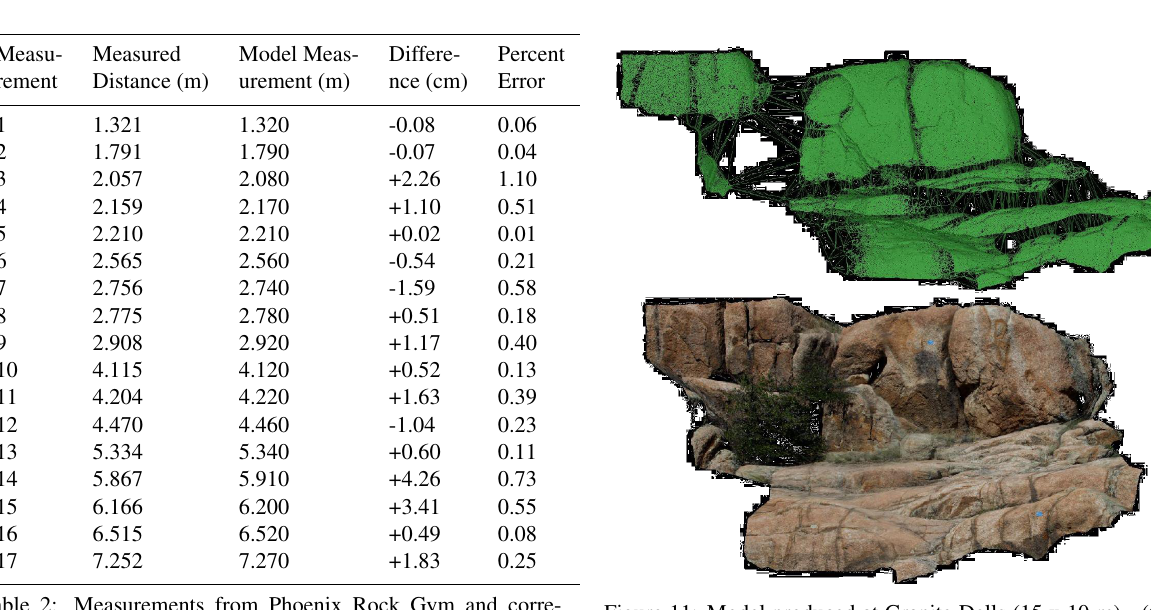
Figure 11: Model produced at Granite Dells (15 x 10 m) - (top) wireframe model - (bottom) same model with draped